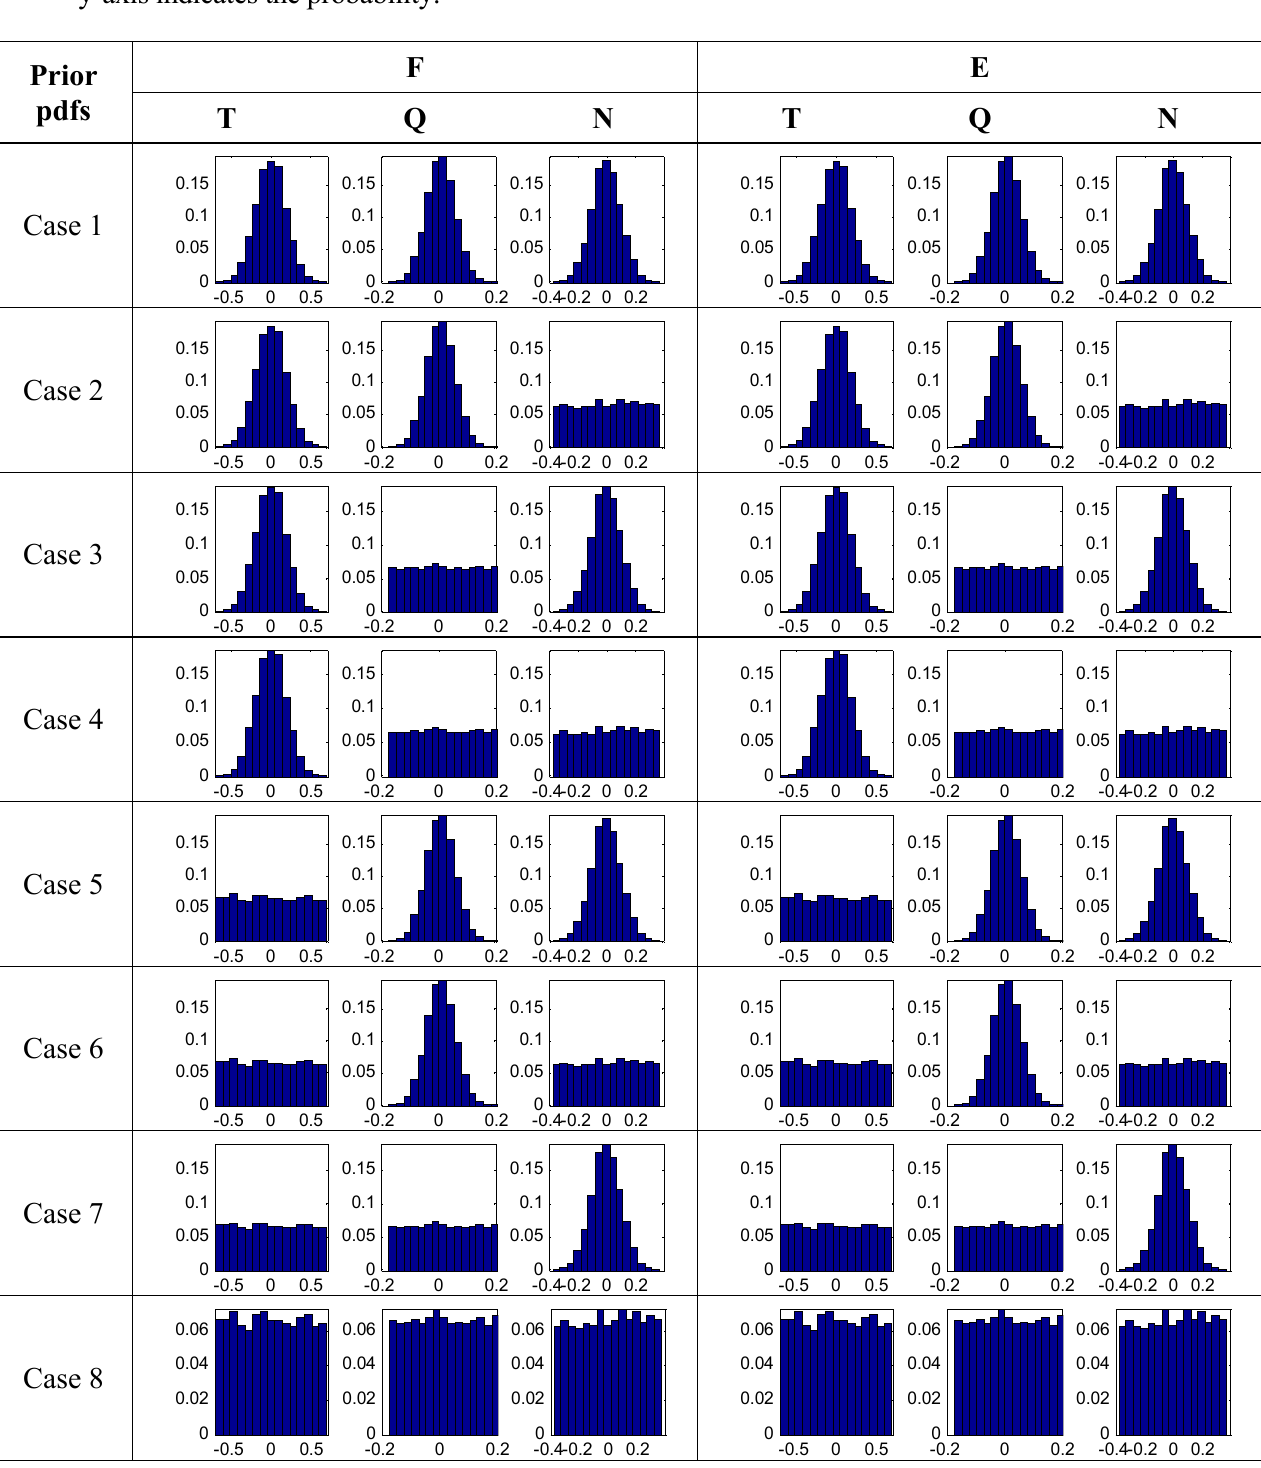
Figure 5. The posterior pdfs of the model variables for the top 100% of the E and F likelihood measures. The x-axis is the change of uncertainty in the model variable and the y-axis indicates the